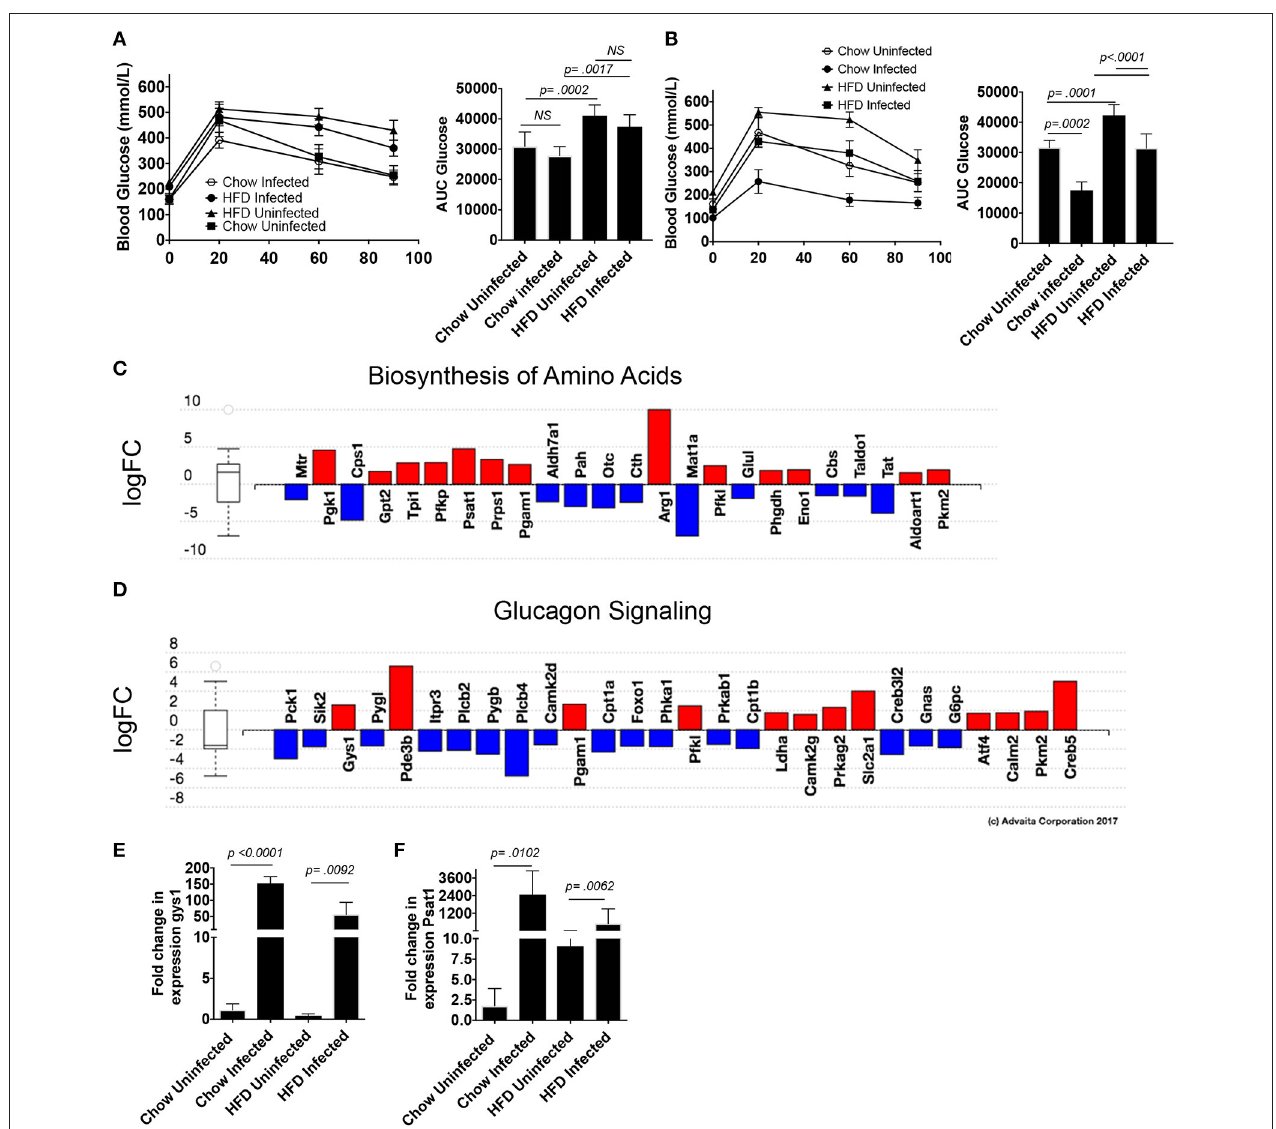
FIGURE 6 | S. mansoni infection improves glucose tolerance and alters hepatic metabolism toward glycogen storage and amino acid biosynthesis. ApoE − / − male mice were fed HFD or standard chow diet for 10 days before infection with S. mansoni . At 5 (A) and 10- (B) weeks post infection mice were fasted for 5h and then administered an i.v GTT. (C,D) Perivascular macrophages and Kupffer cells were sorted from naïve and 10-week S. mansoni -infected C57BL/6 mice, RNA was extracted following Immgen protocols and populations were analyzed using whole-mouse genome Affymetrix Mouse Gene 2.0 ST Arrays. Significantly up (red) and down (blue) -regulated pathways were identified using Advaita Corporation iPathwayGuide. (E,F) QPCR analysis of gys1 and psat1 in whole liver RNA, data are normalized to Chow infected animals. Data in (A,B,E,F) are two combined experiments with 4-8 mice per group in each experiment and the experiment